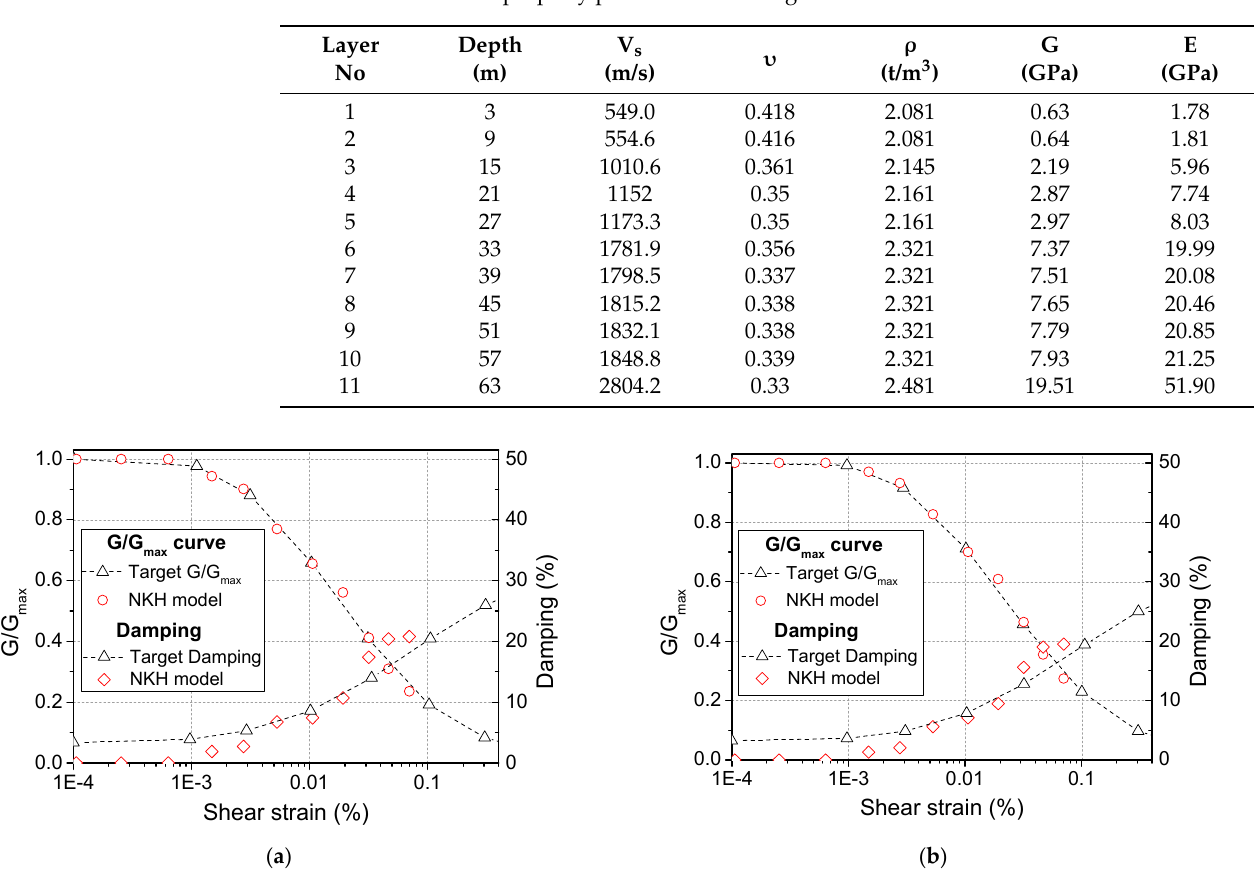
Table 2. Fundamental property profiles for Wolsung NPP.